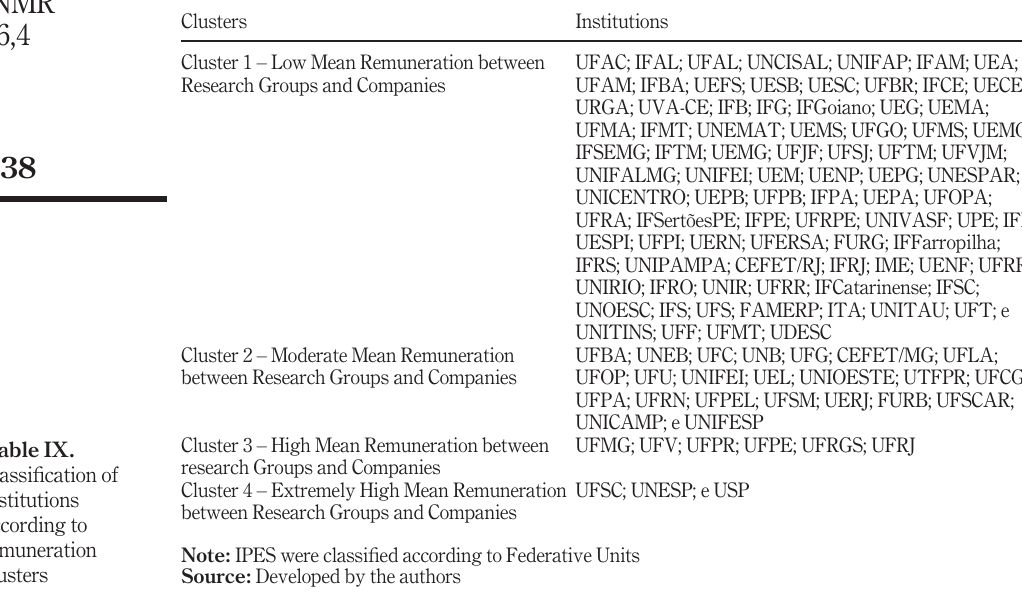
Table IX. Classi fi cation of institutions according to remuneration